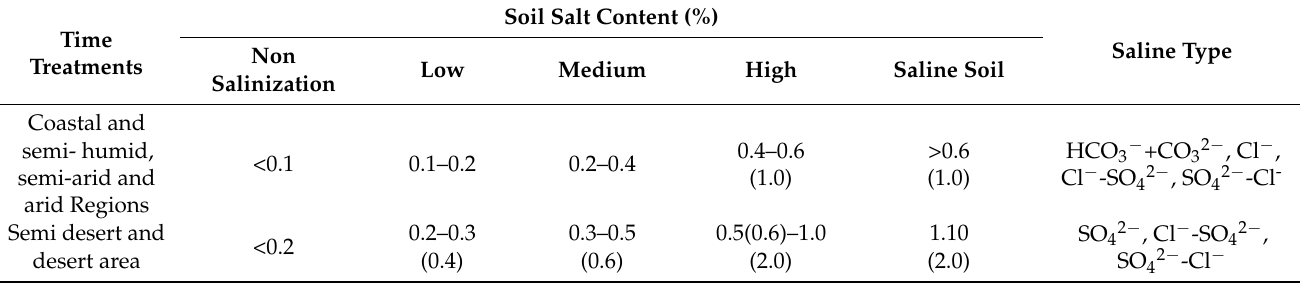
Table 2. Soil salinization classification index [16].